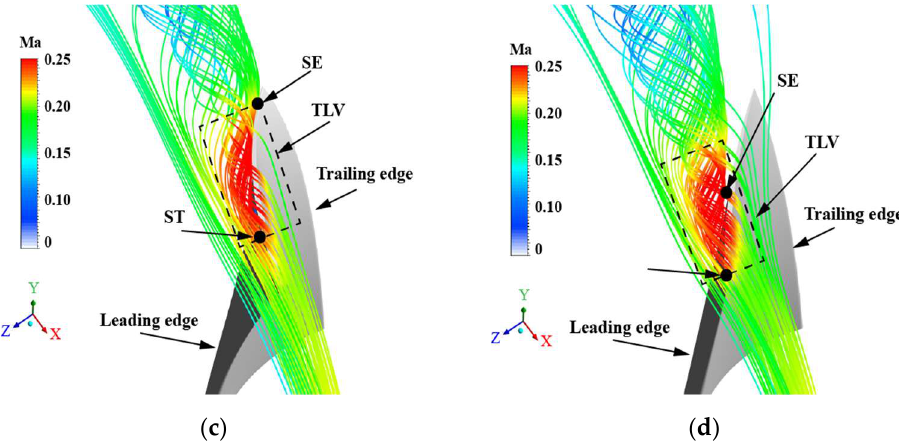
Figure 18. Comparison of tip leakage vortices: ( a ) ORI; ( b ) MES; ( c ) MOS; ( d ) MPS.